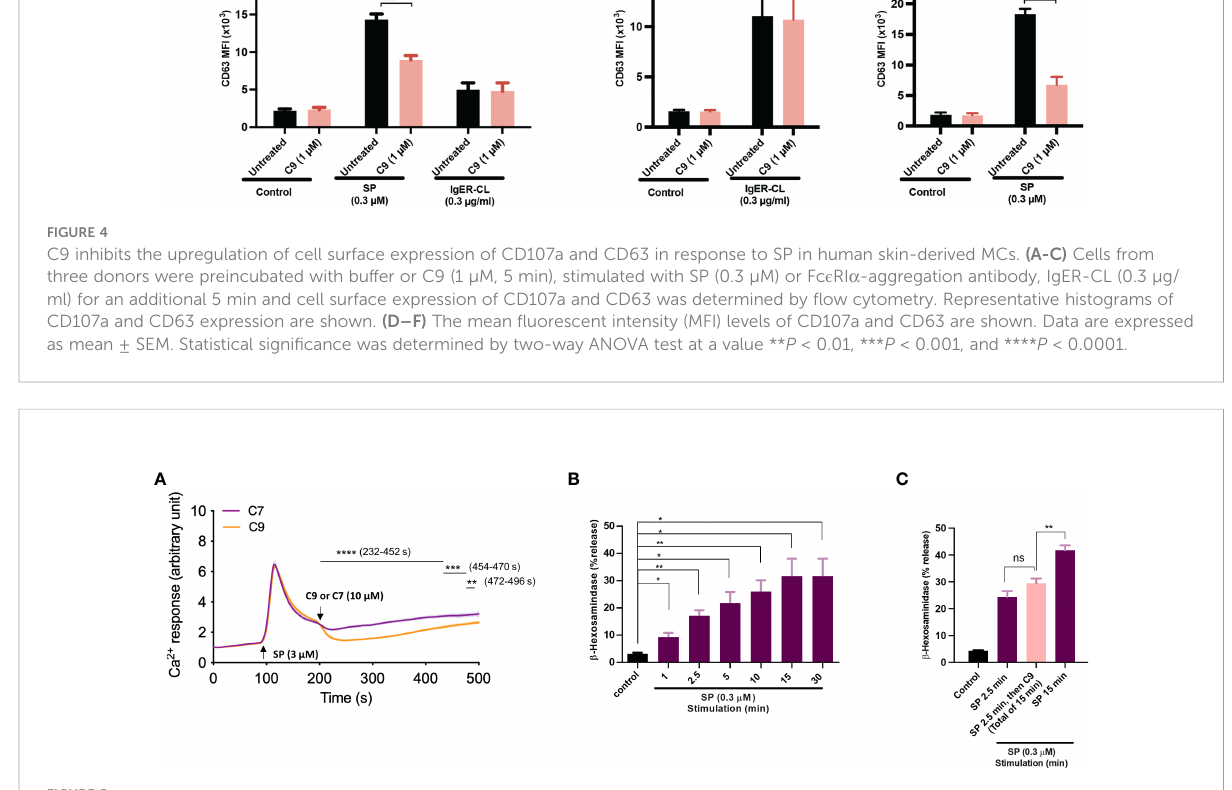
FIGURE 5 Pre-incubation of cells with C9 is not required for its ability to inhibit MRGPRX2-mediated Ca 2+ mobilization and degranulation. (A) Ca 2+ mobilization measurement of Fura-2 loaded RBL-MRGPRX2 cells following stimulation with SP (3 µM). As the response approached the plateau phase, the C9 or C7 (10 µM) was introduced and the response was measured for an additional 5 min. (B) RBL-MRGPRX2 cells were exposed to SP (0.3 µM) and the time-course of degranulation was assayed by measuring the release of b -hexosaminidase. (C) Cells were exposed to SP (0.3 µM) and degranulation was quantitated after 2.5 min (left, purple) or 15 min (right purple). Alternatively, cells were stimulated with SP for 2.5 min and then exposed to C9 (10 µM) for an extra 12.5 min (total of 15 min), and b -hexosaminidase release was determined (middle, pink). Data are expressed as mean ± SEM. Statistical signi fi cance was determined by unpaired t -test for single comparison and one-way ANOVA for multiple comparisons at a value * P < 0.05, ** P < 0.01, *** P < 0.001, **** P < 0.0001, and ns denotes “ not signi fi cant ”